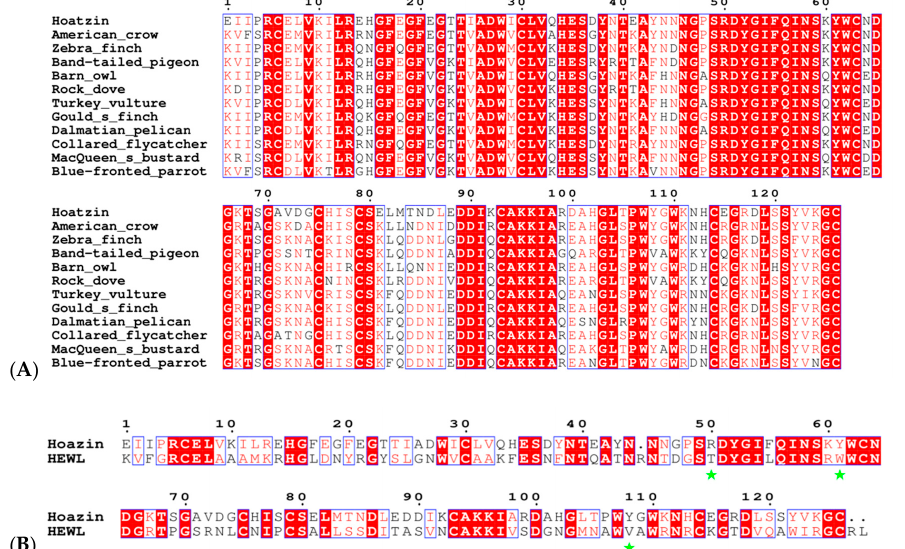
Figure 6. ( A ) Sequences of the proposed avian gut set of GH22 lysozymes: the SWISSPROT/PDB codes and full species names are listed in Supplementary Table S1. ( B ) For comparison, the alignment of Oh Lys with HEWL. The sequence numbers correspond to Oh Lys. Conserved residues are highlighted in red; conservative changes are shown in red text. There is a single deletion at residue 45 in the Oh Lys sequence, and a loss of two amino acids at the C-terminus. The Hoatzin sequence is that reported from the gene sequencing [15], and does not include the two amino acid insertion after residue 1 in the Oh Lys variant. Figure produced using ESPrpt [22]. Three key di ff erences are indicated by * (R50 / T51, Y61 / W62 and Y108 / V109): each of these residues was mutated from its Oh Lys amino acid to that in HEWL, as part of the mutational studies. The first two of these are totally conserved in the avian gut family in ( A ), the latter is either Y or